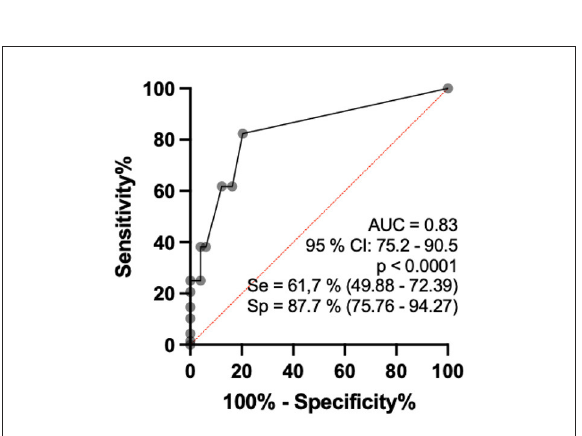
FIGURE4 Analysis by the ROC curve of the percentage indices of altered nerves among the nerves evaluated per individual comparing the groups of healthy individuals and contacts of patients with HD aged 15–60 years.